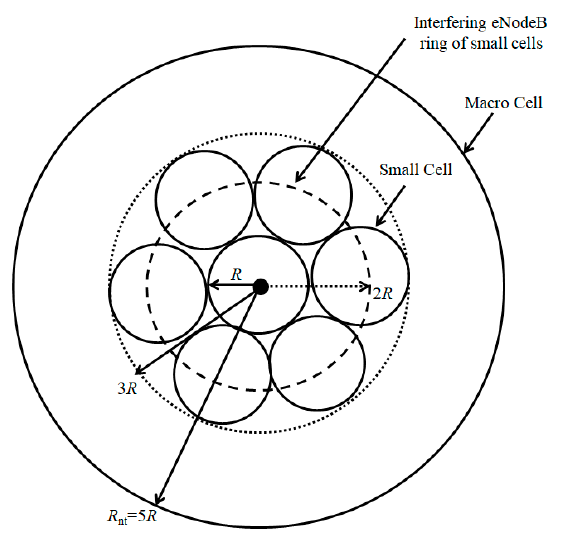
Figure 3. HetNet scenario for deployment of small cells near the macro cell eNodeB.